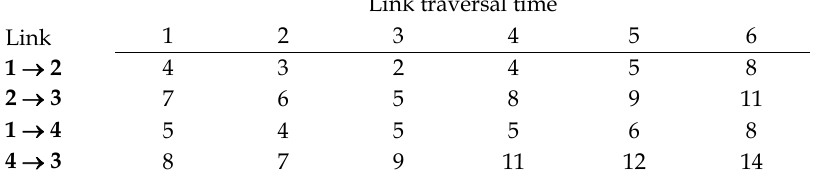
Link traversal time